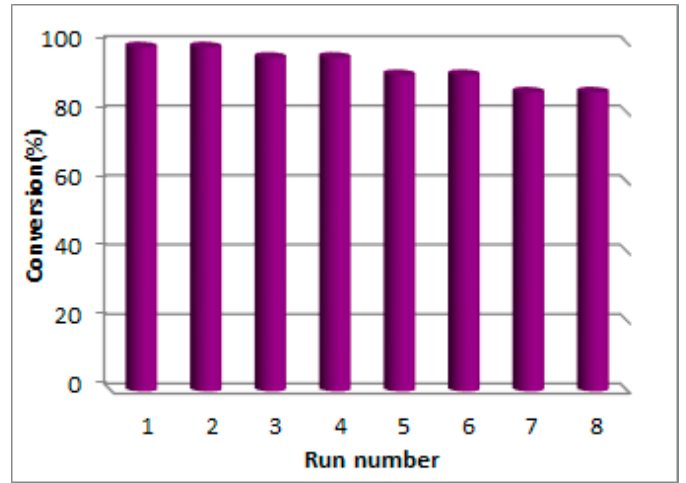
Figure 5. Recycling experiment of Lac/Fe 3 O 4 /GO for oxidative coupling between 2,3- dihydrophthalazine-1,4-dione and p-toluene sulfinic sodium salt in the presence of aerial oxygen and in the phosphate buffer solution (PBS) (0.1 M, pH = 5) at room temperature for 24 h.